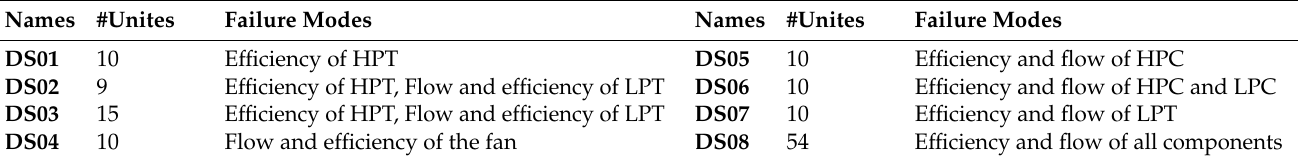
Table 3. Overview of the N-CMAPSS